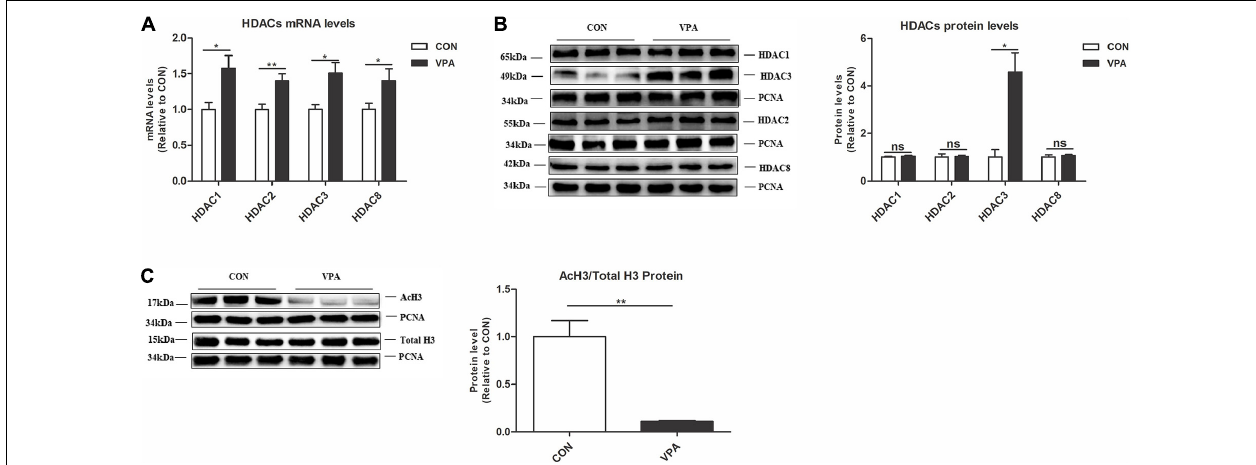
FIGURE 3 | Levels of HDAC3 and histone acetylation in the PFC of VPA-exposed offspring. (A) Levels of HDAC1, HDAC2, HDAC3, and HDAC8 mRNA expression in the PFC from the CON and VPA groups, as detected using qPCR and normalized to GAPDH ( n = 10 per group). (B) Western blot and quantification analyses of HDAC1, HDAC2, HDAC3, and HDAC8 protein in the nuclear fraction of PFC from CON and VPA groups ( n = 3 per group). (C) Western blot and quantification analyses of AcH3 and total H3 proteins in the nuclear fraction of PFC from the CON and VPA groups, as normalized to PCNA; the level of histone acetylation was measured as the ratio of AcH3 to H3 ( n = 3 per group). Each experiment was repeated at least three times. The values are means ± SEMs. Student’s t -test, * P < 0.05, ** P < 0.01, ns, not significant; VPA, valproic acid; PFC: prefrontal